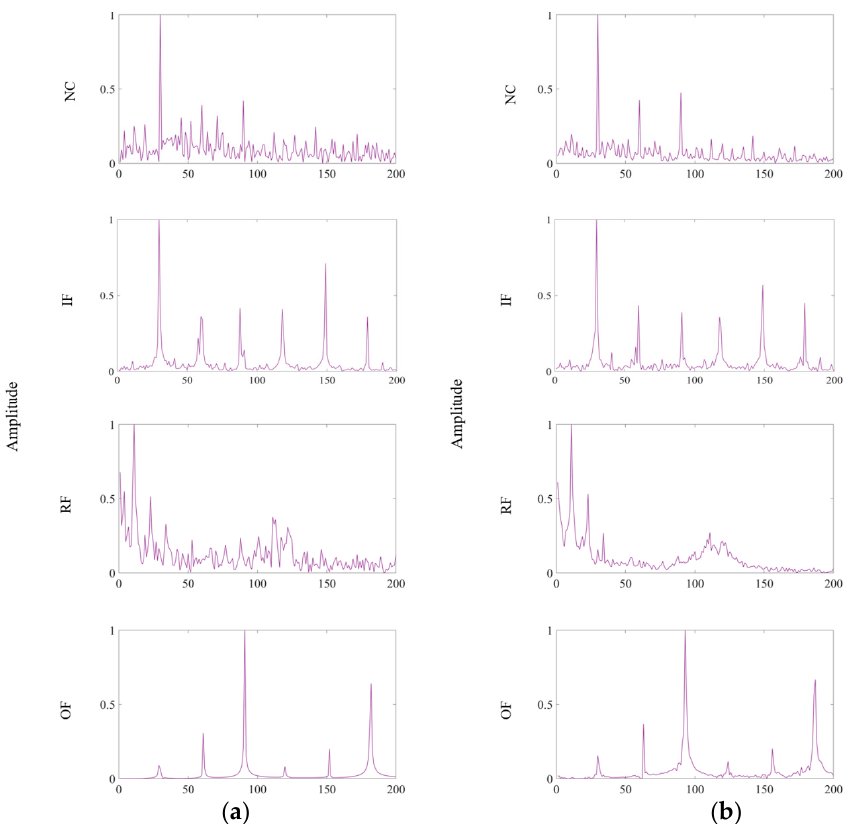
Figure 13. Comparison between real and generated signals for dataset C: ( a ) Raw signals, ( b ) Gen- erated signals.